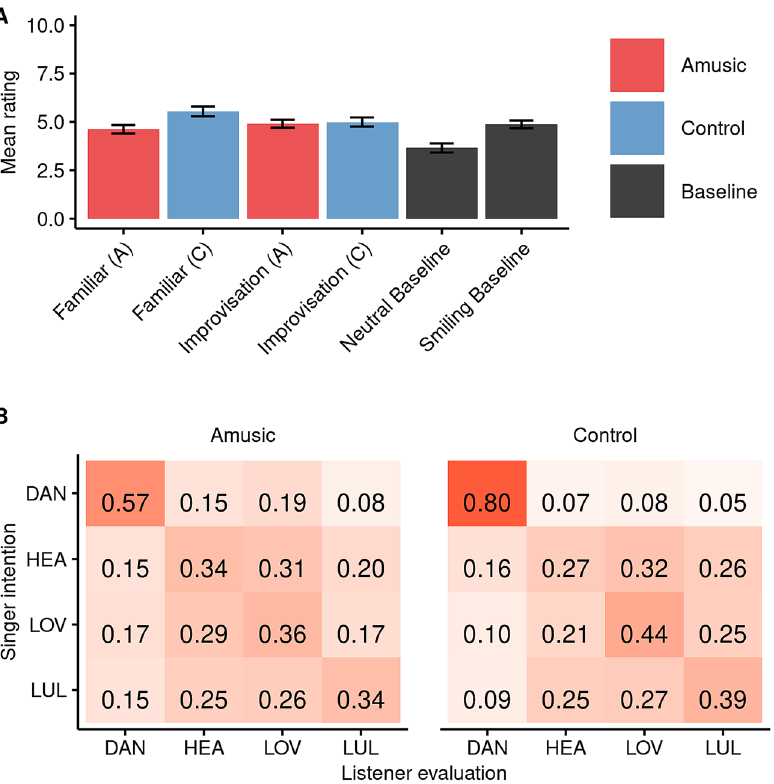
du Pays) or free improvisations, separately by singer group (amusic, control). Two amateur singers who sang Happy Birthday with a smiling or neutral face served as baseline. All categories scored significantly higher than the neutral baseline recordings, and were not lower than the neutral smiling recordings, consistent with implicit enjoyment of the task. ( B ) shows a confusion matrix for improvisation excerpts sung in response to a prompt to sing a dance song (DAN), a healing song (HEA), a love song (LOV), or a lullaby (LUL), separately by singer group (amusic, control). Scores along the descending diagonal are correct evaluations, and were more